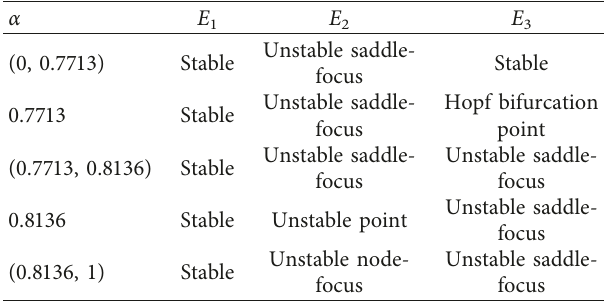
Table 3: The types of the